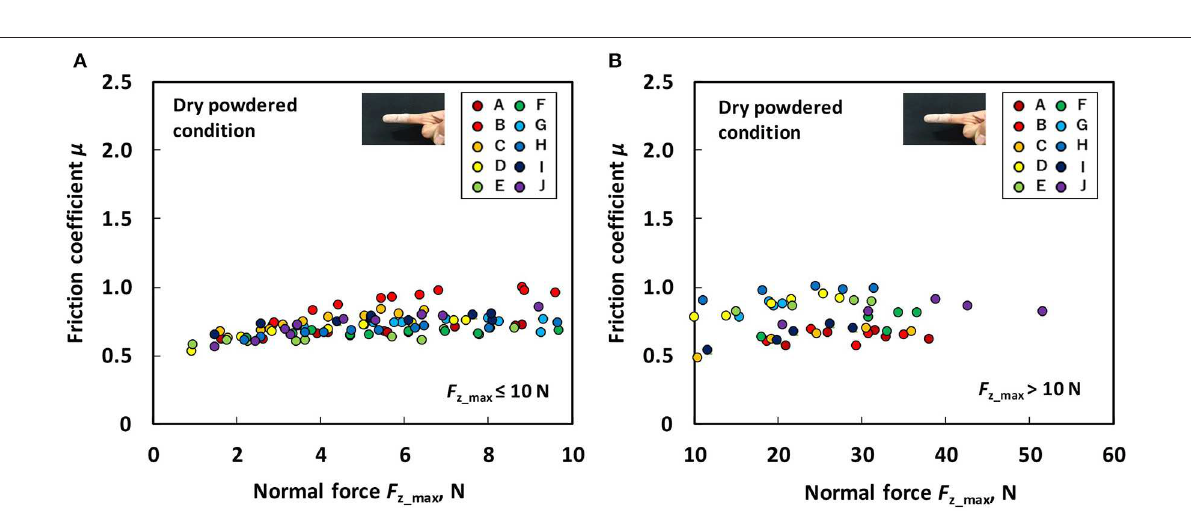
FIGURE 5 | Relation between normal force ( F z_max ) and friction coefficient ( µ ) under the dry powdered condition (A) during the low normal force condition ( F z_max ≤ 10N) and (B) during the large normal force condition ( F z_max >